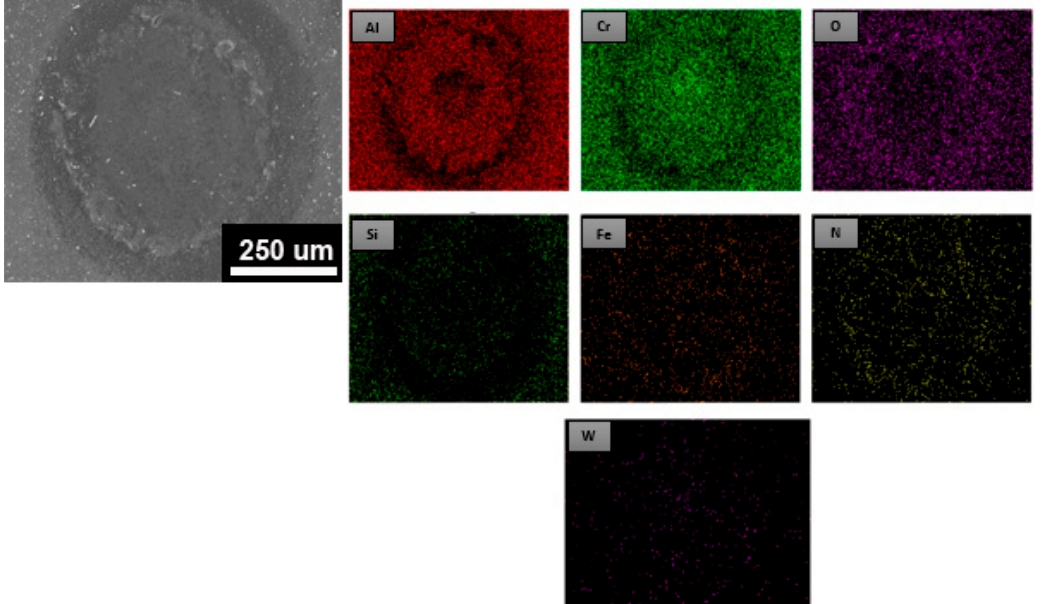
Figure 9. SEM and EDS element mapping of PN + AlCrSiN at high temperature (500 °C) after 200k impacts.